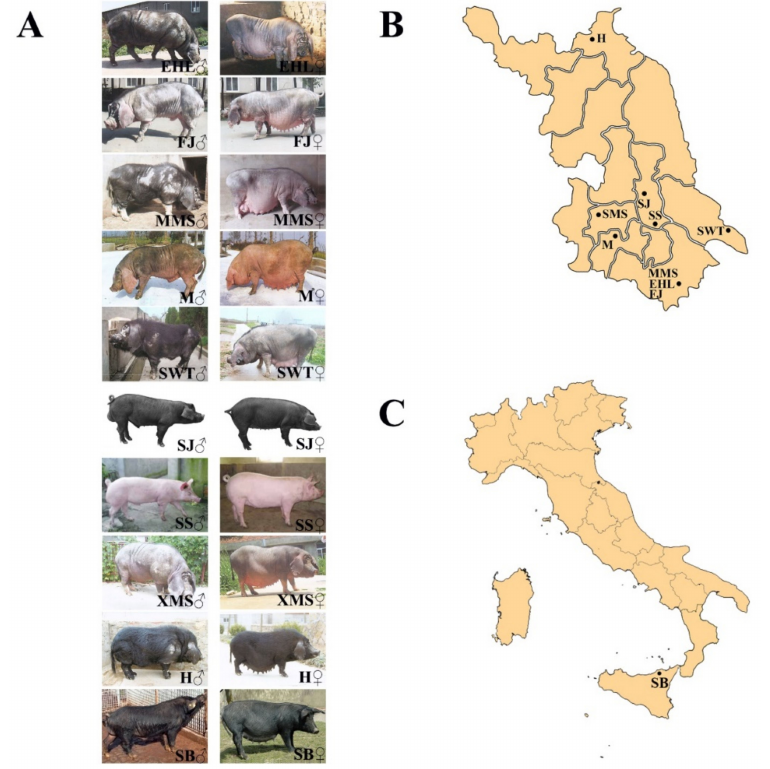
Figure 1. The photos of the ten native pig populations and geographical distribution. ( A ) The photos of the ten native pig populations; ( B ) geographical distribution of nine Jiangsu native pig population in Jiangsu province; ( C ) geographical distribution of Italic native pig breed in Italy. EHL, Erhualian; FJ, Fengjing; MMS, Middle Meishan; M, Mi; SWT, Shawutou; SJ, Sujiang; SS, Sushan; SMS, Small meishan; H, Huai; SB, Sicilian black pig; LW, Large White; DRC,